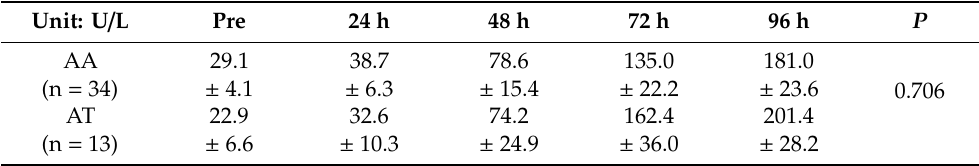
Table 5. Changes in aspartate transaminase (AST) after eccentric exercise according to the myostatin A55T